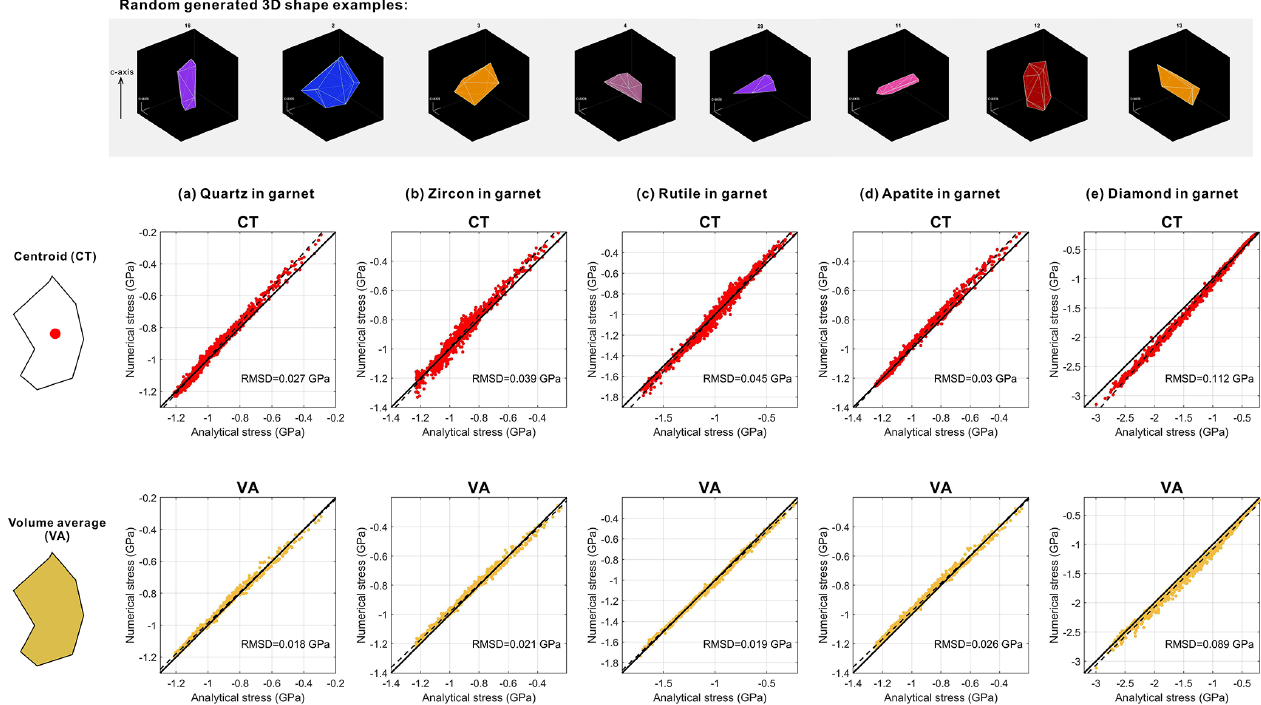
Figure 7. The 500 randomly generated inclusion shapes (top panel for examples) calculated with the finite-element method (vertical axis) and analytical method (horizontal axis). All three normal stress components are plotted together in each diagram. The crystallographic c axis orientation is randomly chosen along one of the geometrical principal axes. The red and orange dots show the comparison of FE (numerical) results and analytical results for the normal stress components, respectively. Each dot represents a normal stress component calculated for one randomly generated inclusion shape. The red dots show the stress evaluated at the centroid point (CT); the orange dots show the volumetrically averaged (VA) stress within the inclusion. The raw data can be found in the Supplement and the generated 3D random shape can be viewed in the accompanying .gif